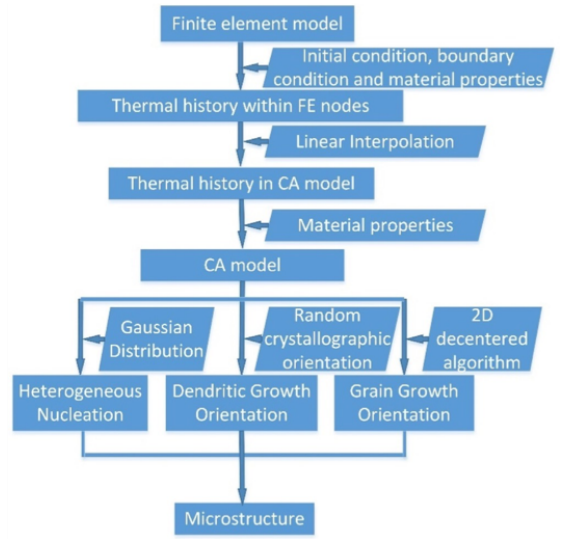
Figure 7. Flowchart of CAFE coupling as proposed by Zhang et al.